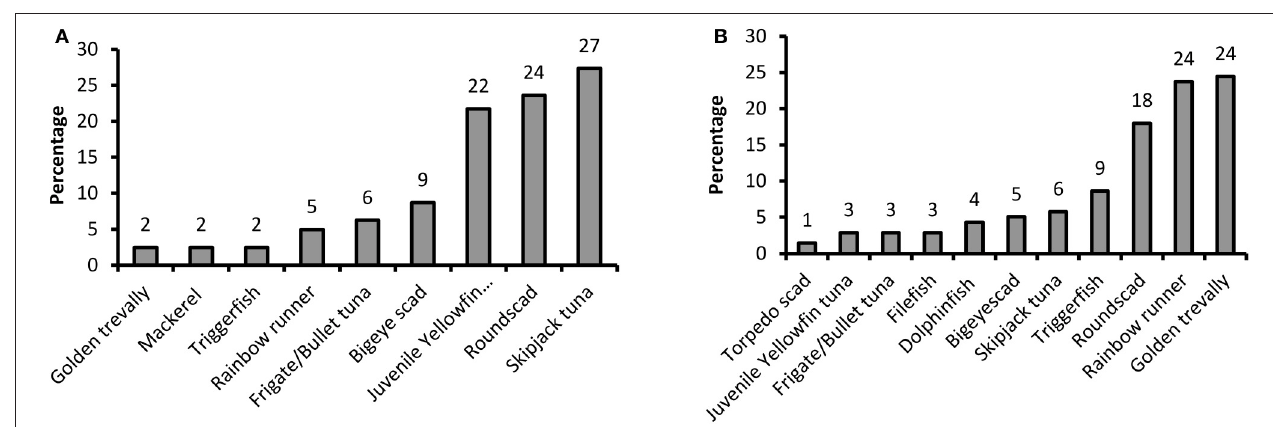
FIGURE 4 | Target fish species mentioned by fishers during interview (A) and proportion of occurrence of various fish species as pioneers in anchored FADs according to respondents (B) . Numbers are percent of the total interviewees that mentioned given information ( n = 46).